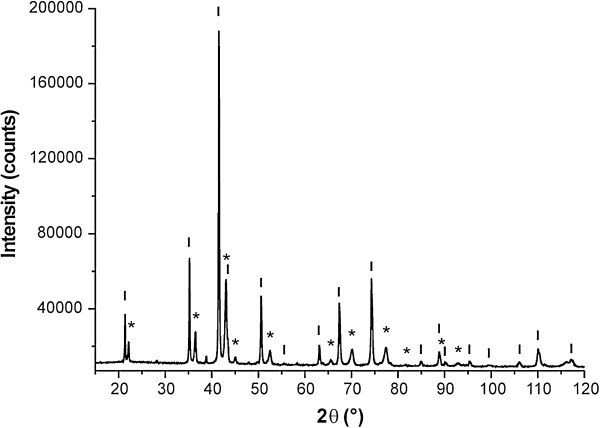
XRD pattern of the sample prepared by heating of 1a up to 600°C. (*) CoFe2O4, (|) Co3O4.